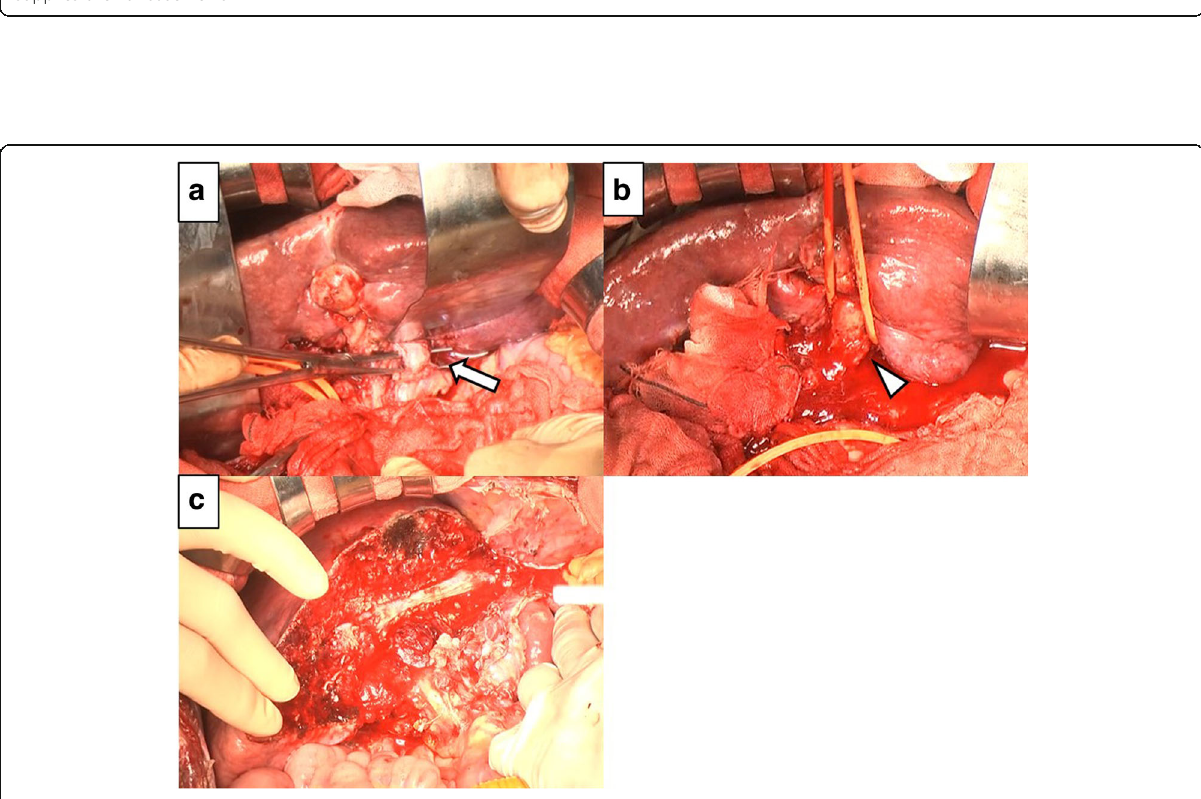
Fig. 5 Intraoperative findings of the second surgery. a Identification of the left hepatic artery (arrow). Adhesion was observed because of the first surgery. b The left branch of the portal vein (arrowhead), firmly adhered. The left branch of the portal vein and left branch of the bile duct are taped together. c The main trunk of the middle hepatic vein is exposed in the transection